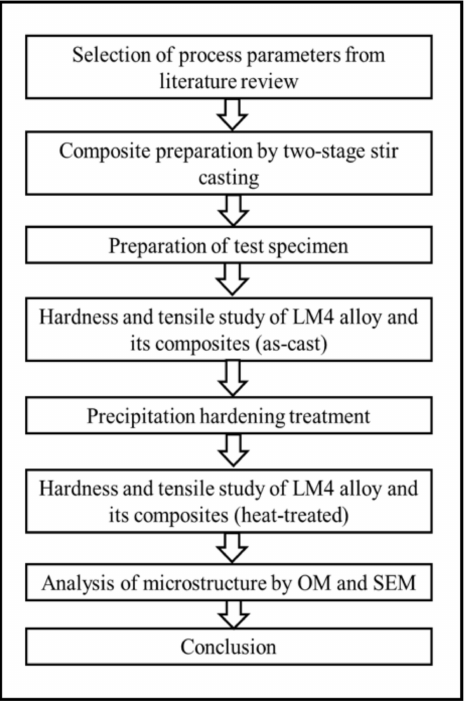
Figure 1. Flow chart of the methodology followed in the present